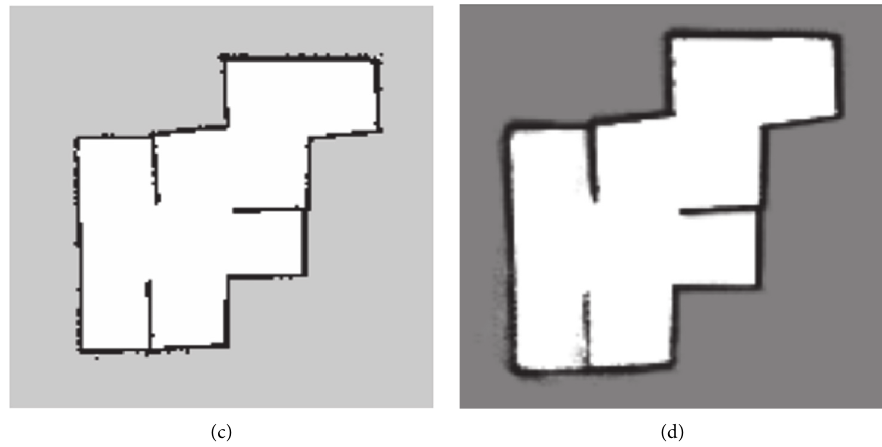
Figure 10: Constructed map: (a) RGB-D, (b) Hector-SLAM, (c) GMapping, (d) Cartographer.